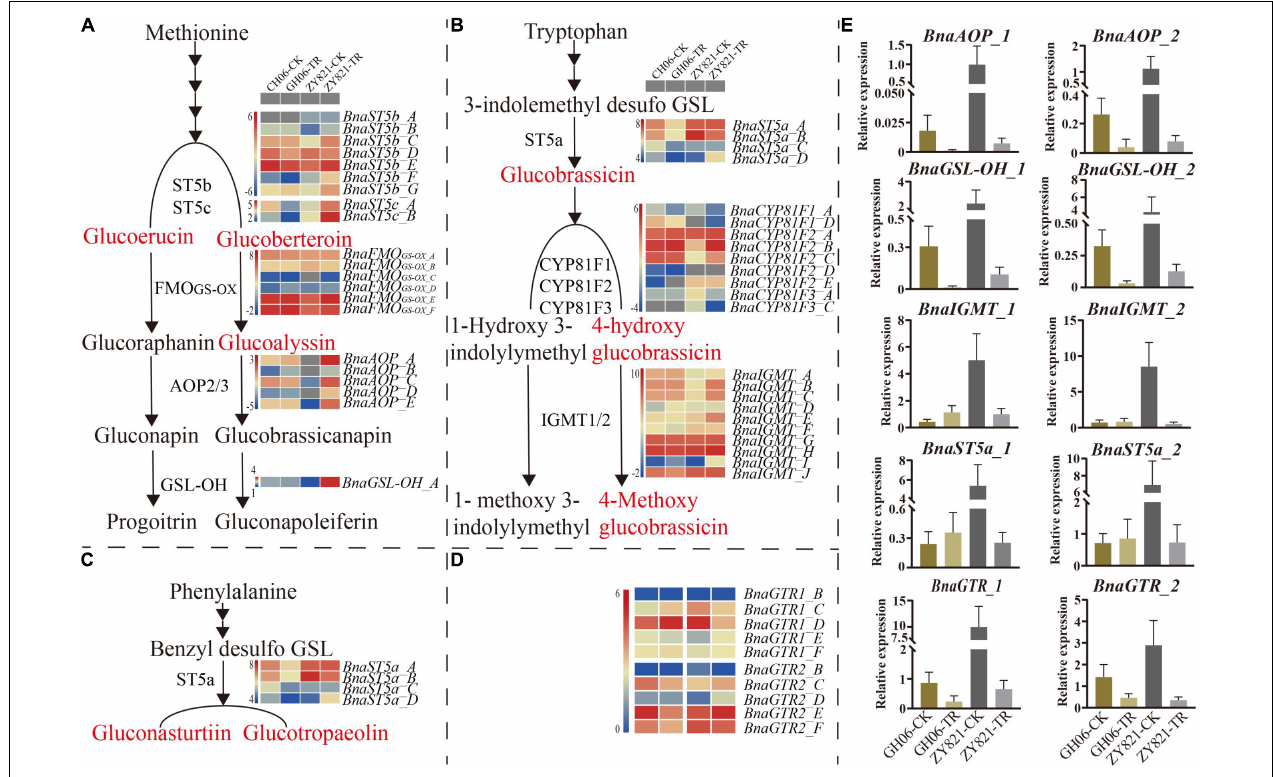
FIGURE 5 | The relative expression levels of GSLs genes in siliques of rapeseed at 35DAP (A) The gene expression profiles of Aliphatic GSL pathway at 35DAP; (B) The gene expression profiles of Indolic GSL pathway at 35DAP; (C) The gene expression profiles of Aromatic GSL pathway at 35DAP; (D) The gene expression profiles of GSL transporters ( BnaGTR1 and BnaGTR2 ) at 35DAP; (E) RT-qPCR validation of GSLs (biosynthetic and transporter) gene expression from the RNA-seq data at 35DAP. Red highlighted compounds are significantly differential common GSLs in GH06 and ZY821. Error bars represent the means ± SD of biological replicates. CK, the control; TR, shading treatment; DAP, days after pollination.